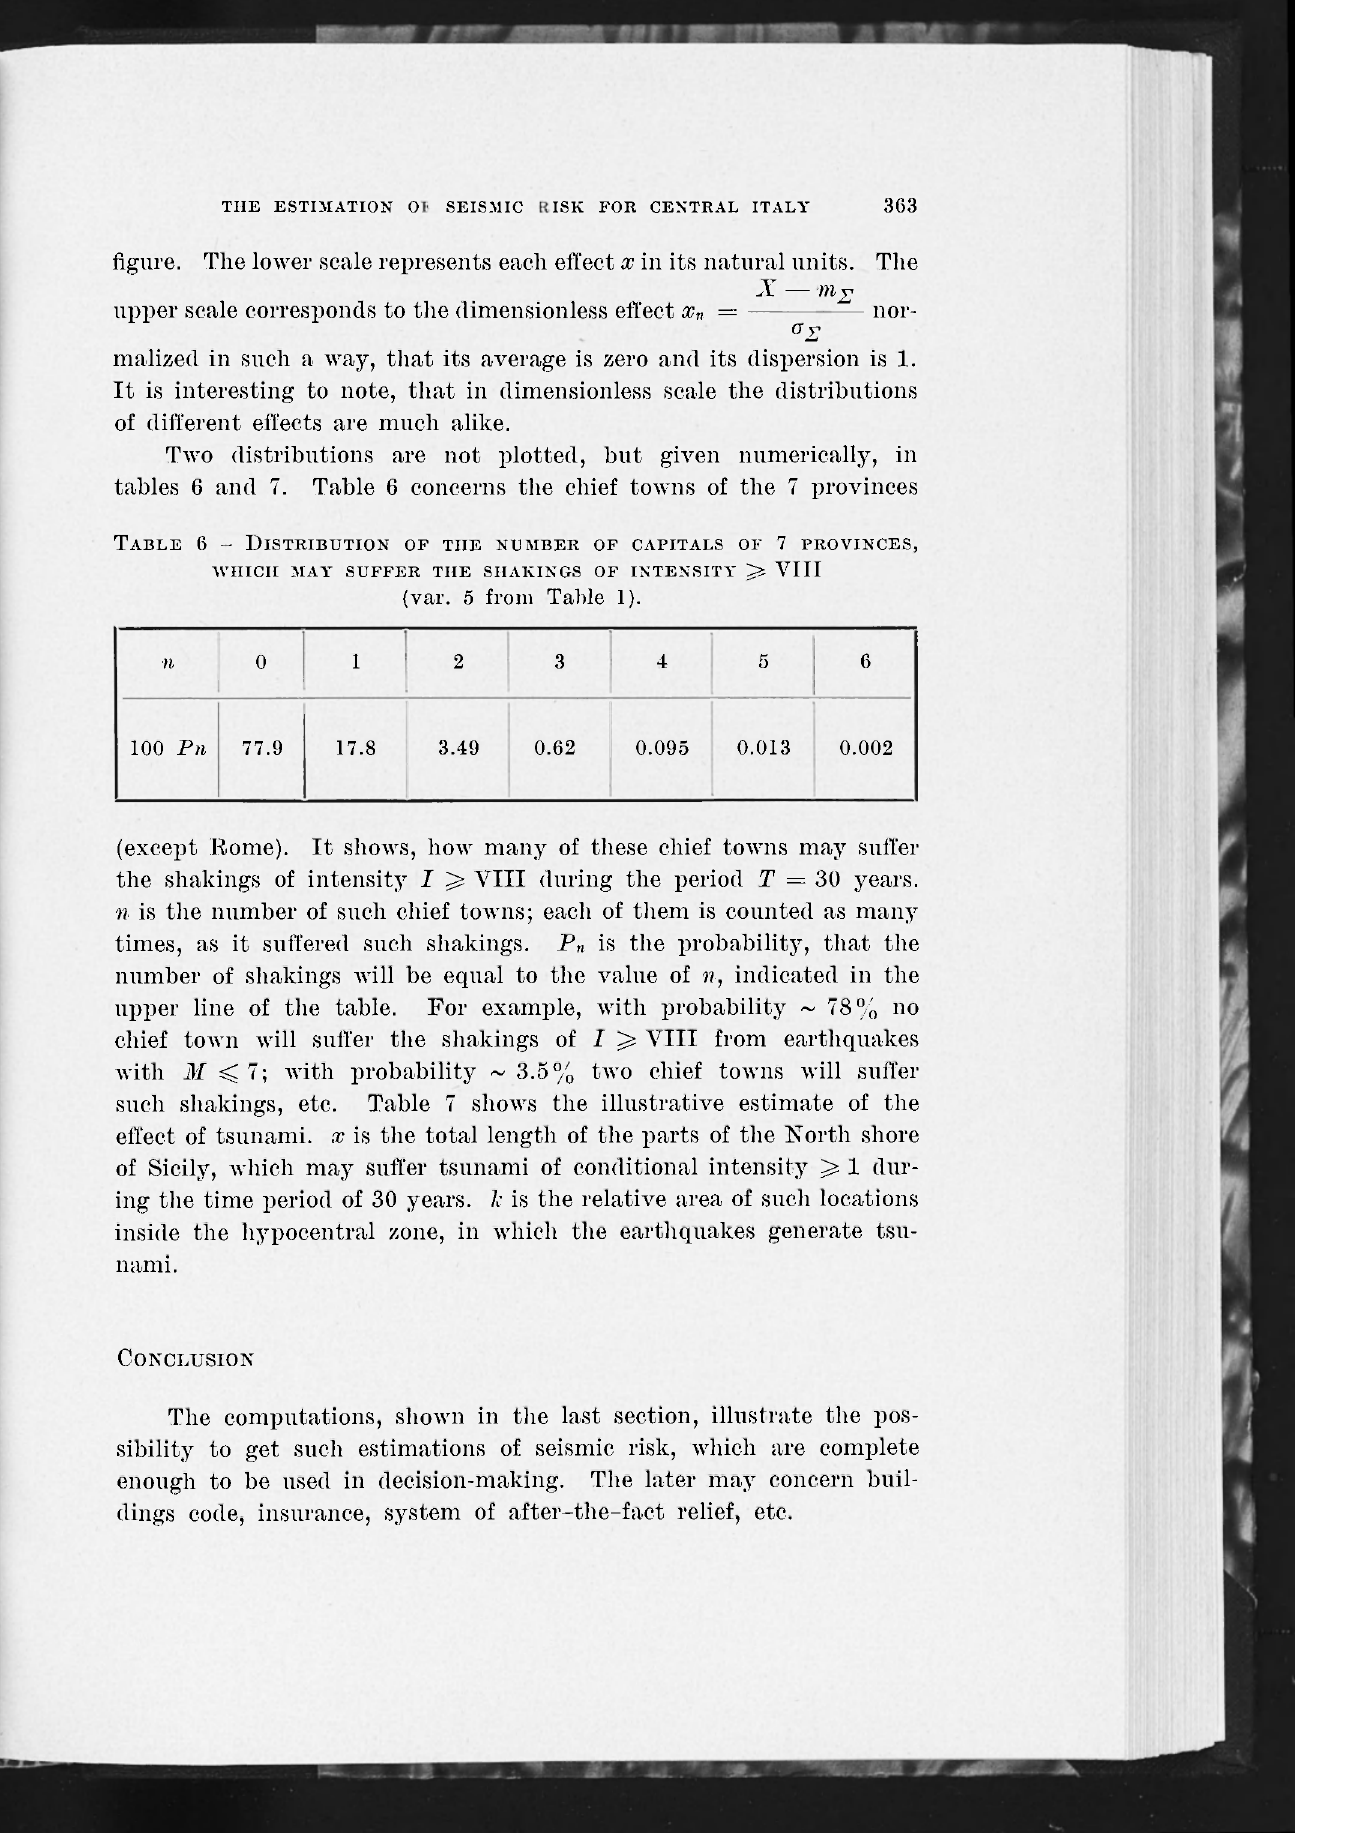
figure. The lower scale represents each effect x in its natural units. The upper scale corresponds to the dimensionless effect x n = — - nor- malized in such a way, that its average is zero and its dispersion is 1.